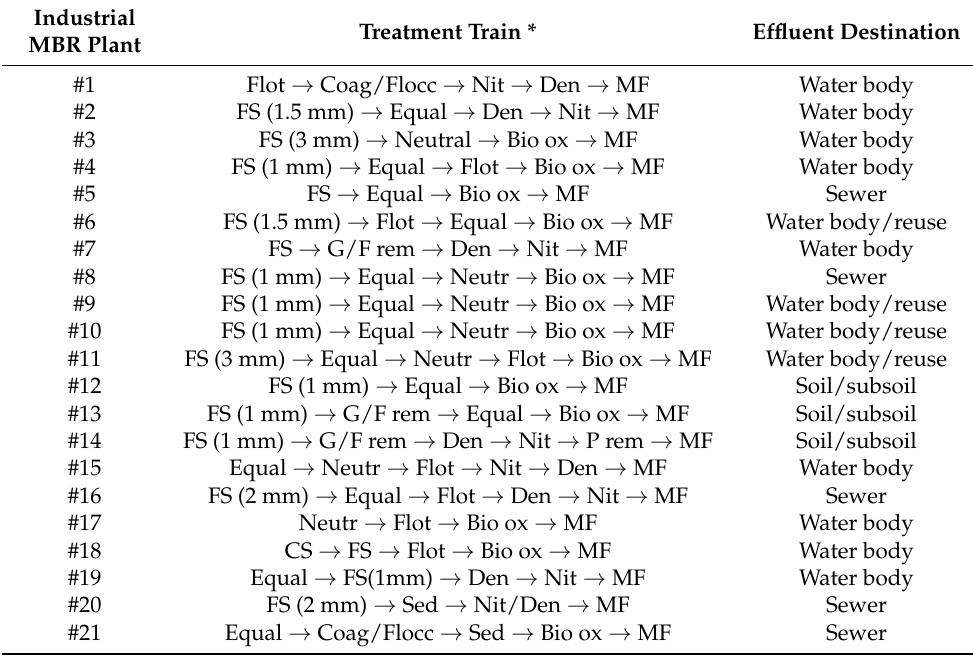
Table 3. Treatment train and effluent destination of the industrial MBR plants.